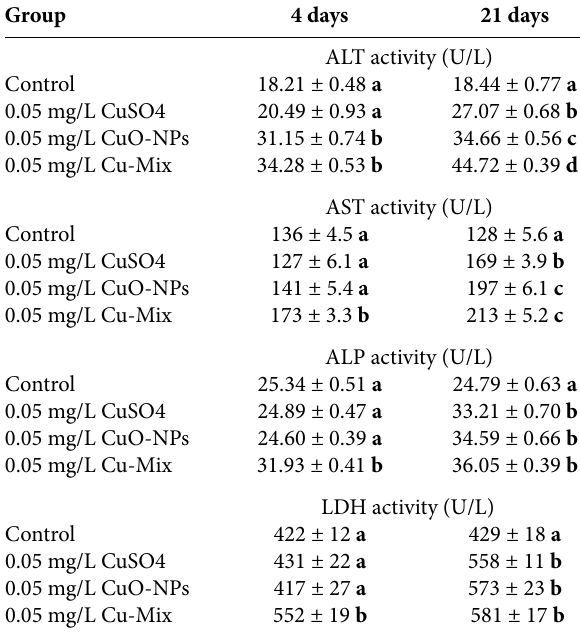
Table 1. Effects of individual and co-exposure of CuSO 4 and CuO- NPs on plasma enzyme activity of O. niloticus Group 4